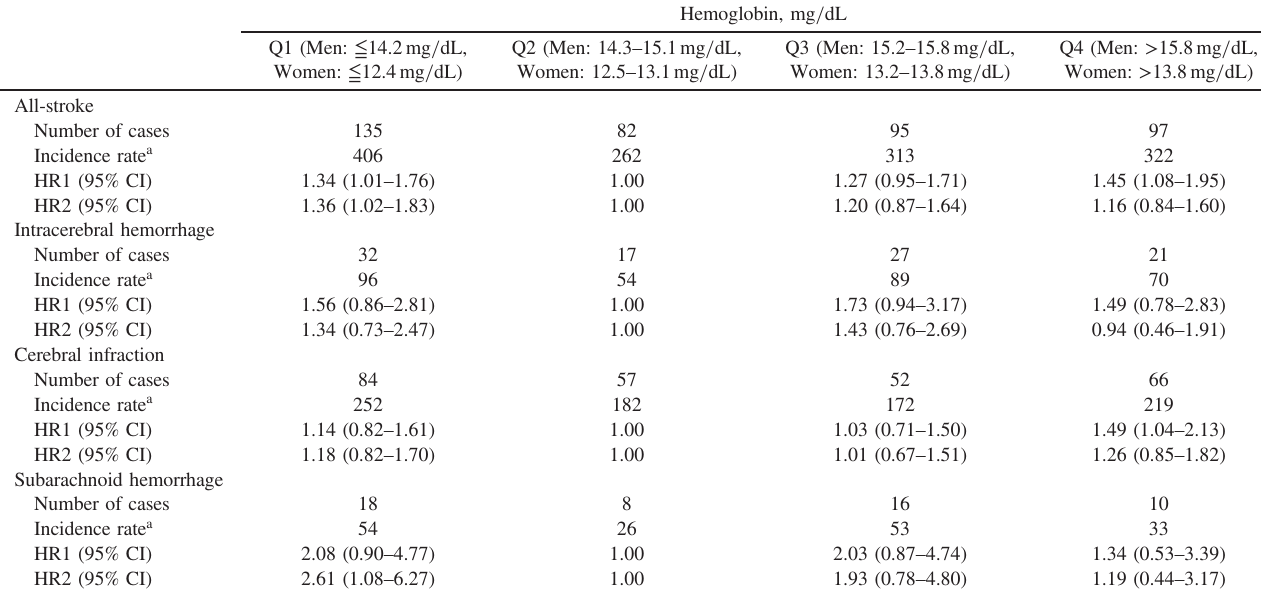
Table 2. Hazard ratios based on total quartiles of sex-speci fi c hemoglobin and adjusted for potential confounders